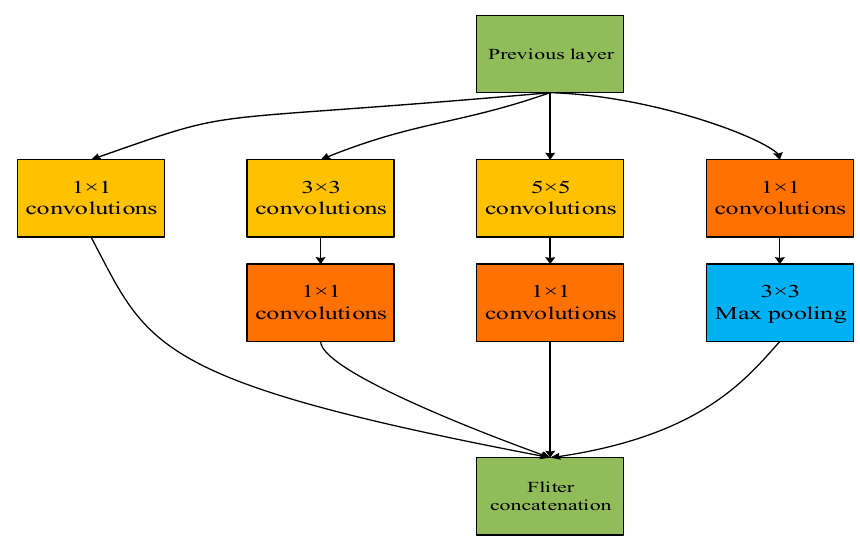
Figure 3. Inception structure model.